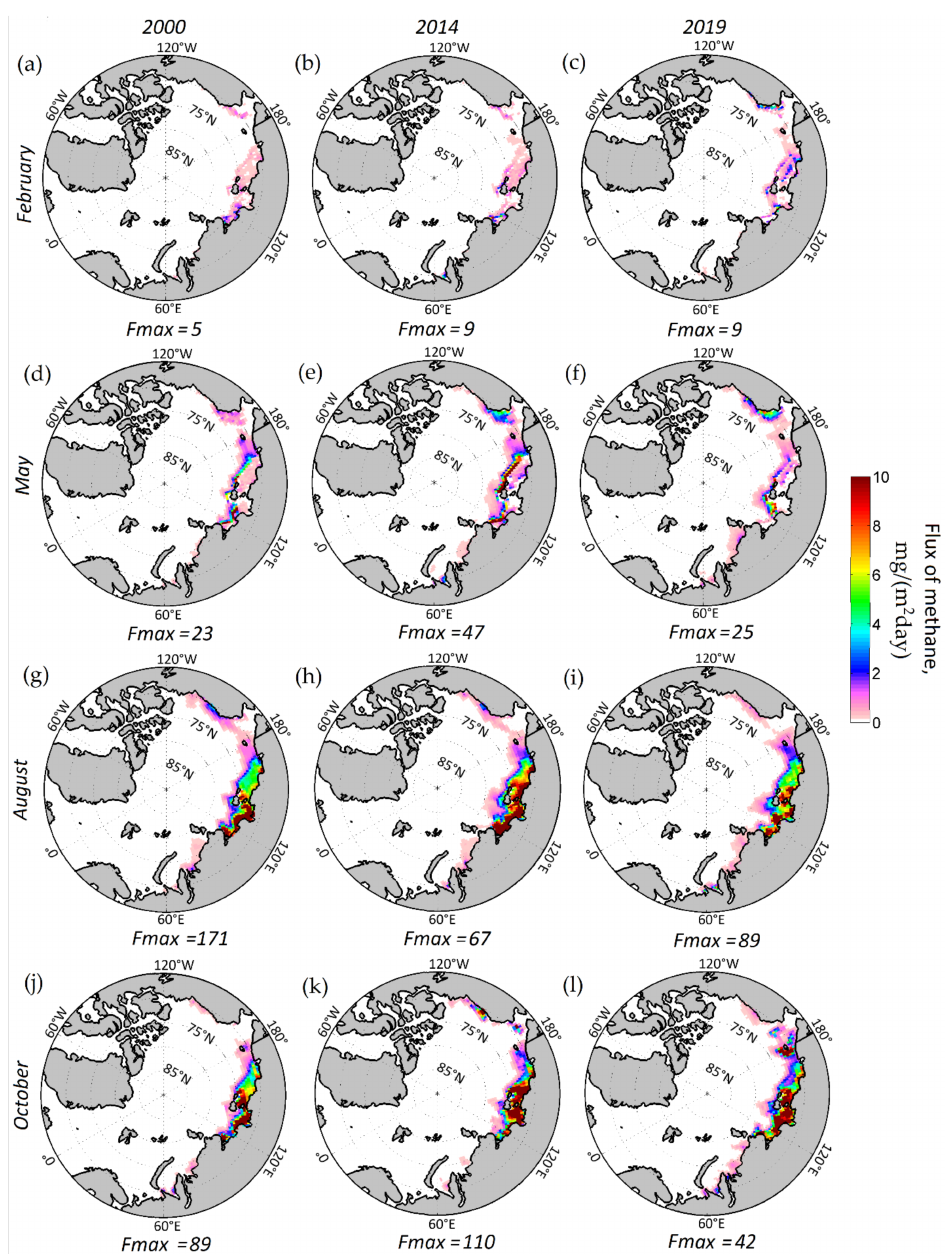
Figure 7. The maps of methane emissions to the atmosphere (in mg/m 2 per day) simulated for the ( a – c ) February, ( d – f ) May, ( g – i ) August and ( j – l ) October 2000, 2014 and 2019. Fmax is the maximum emission in a given